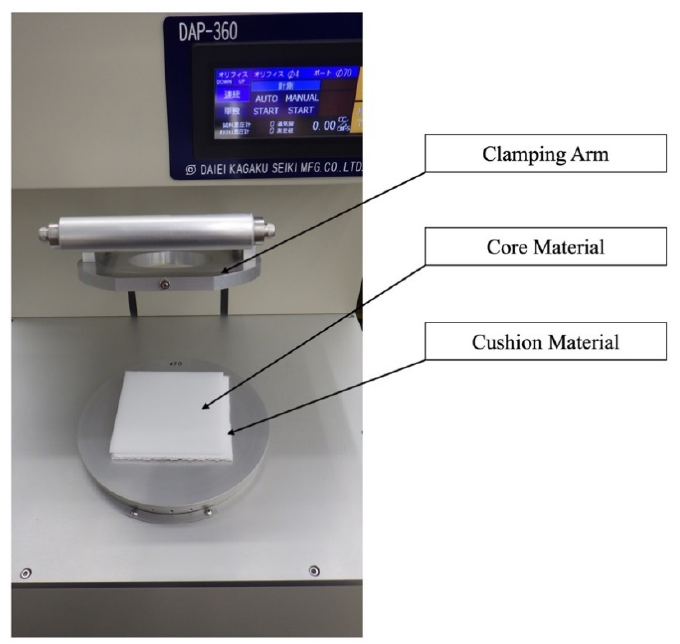
Figure 4. Air permeability test using a Digital Frazir Type Air Permeability Tester.